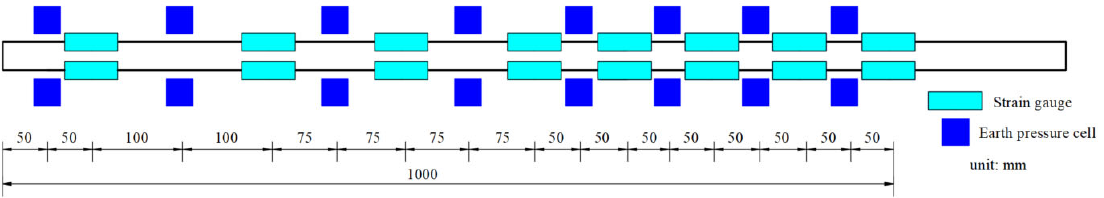
Figure 2. Installations of strain gauges and earth pressure cells.